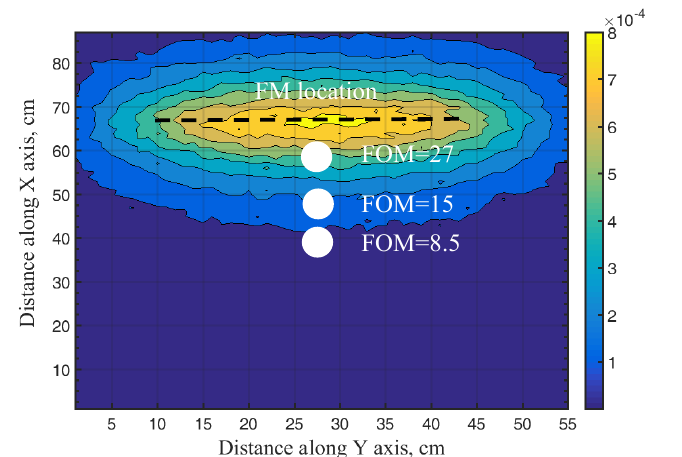
Fig.1 Experimental detector of FM in concrete structures.